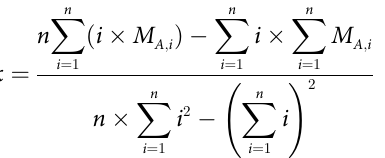
nate system, and the raster data were resampled to a resolution of 30 m.